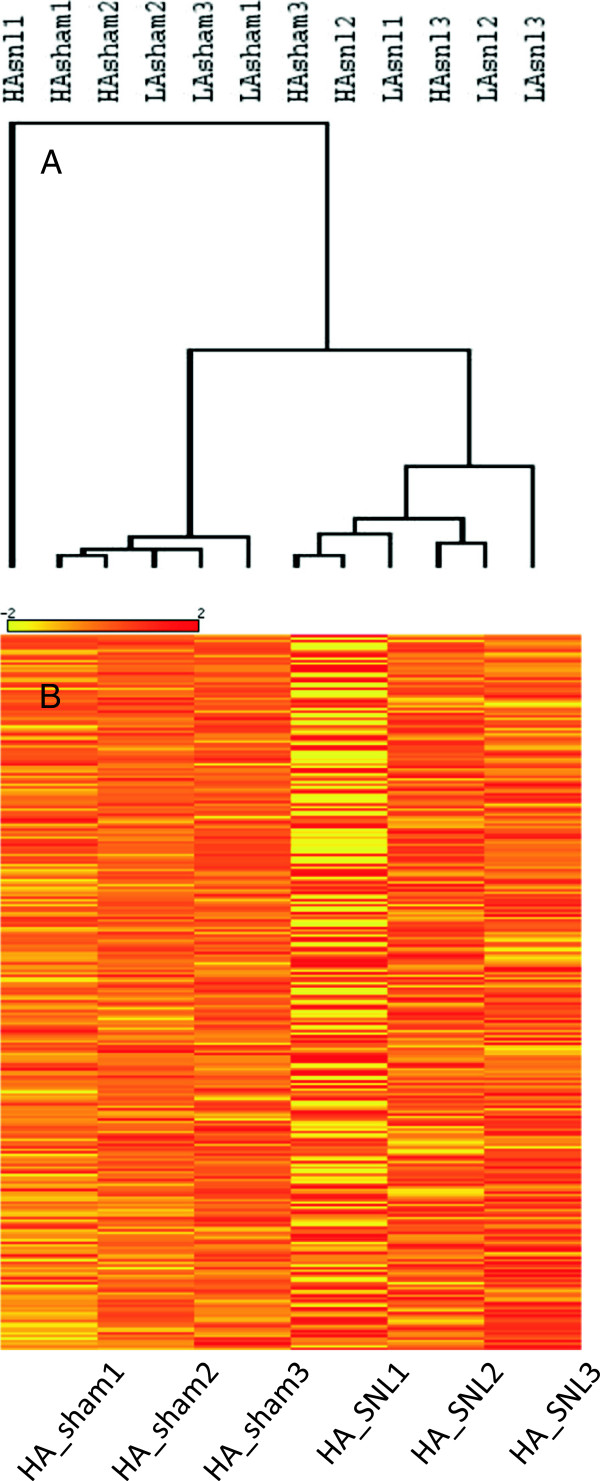
Outlier status of the HA_SNL1 pool. A) Hierarchical dendrogram based on pool similarity and B) HEAT maps [24] both illustrate the outlier status of the HA_SNL1 pool. HEAT map columns use color to represent the 284 miRNAs in the 3 HA_sham pools and the 3 HA_SNL pools. The miRNAs are arranged in decreasing order of average RPM in the HA_sham group. Color (scale above) represents relative RPM where 0 (orange) is the mean RPM of the 6 pools and +2 (red) and −2 (yellow) represent ±2 standard deviations [24].